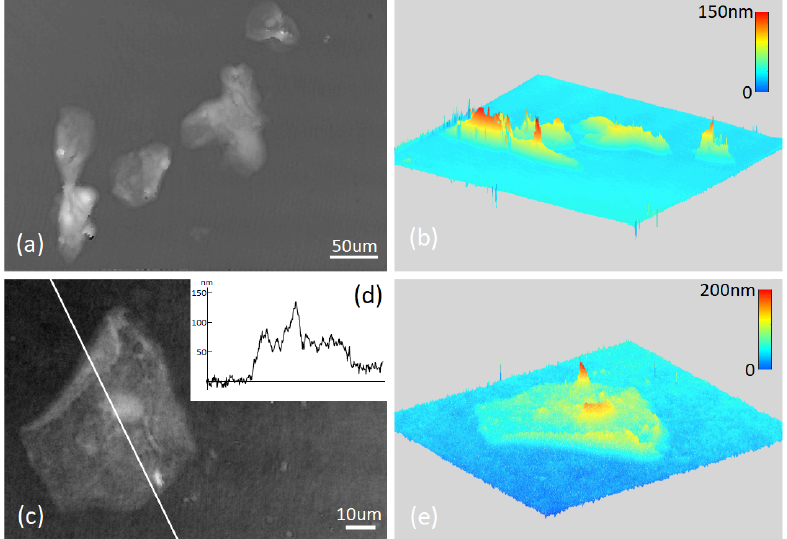
Figure 4. Results for buccal epithelial cells on glass slides for two magnifications: ( a ) phase image and ( b ) a rendered 3D image of the thickness profile recorded using a 10 × /0.3 MO providing a spatial and depth resolution of approximately 2.1 µ m and 1 nm, respectively; ( c ) phase image of a single cell with a 50 × /0.8 MO providing a spatial and depth resolution of approximately 0.79 µ m and 1 nm, respectively, and ( d ) shows the height profile along the white line in this phase image; and ( e ) a rendered 3D image of the thickness